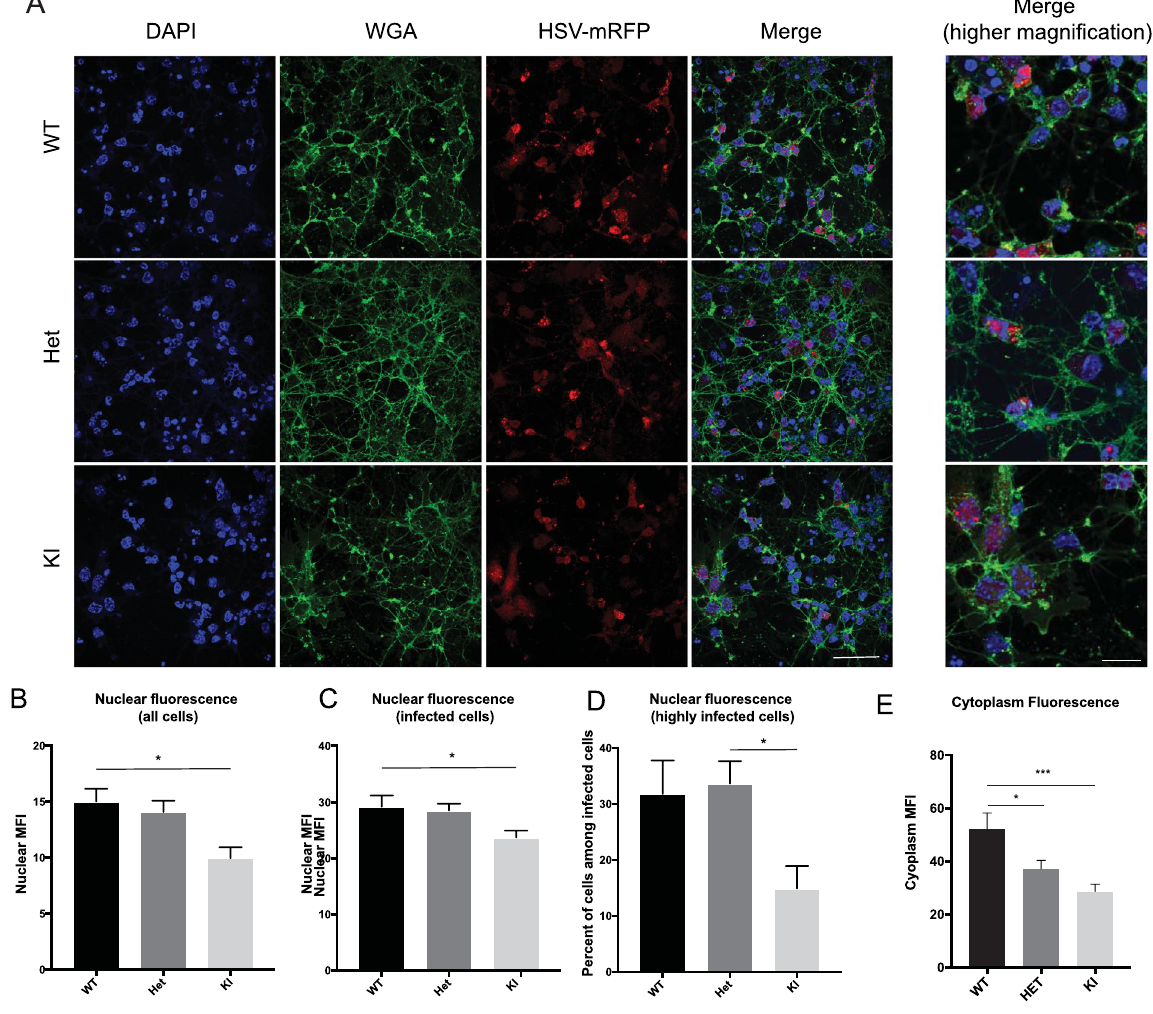
Figure 2. Monitoring HSV infection in nucleus and cytoplasm of neurons. ( A ) Representative images of WT, Het and KI lines infected with HSV-VP26-RFP at the M.O.I. of 1 at 8 h post-infection. Cells were stained for DAPI (blue), WGA-488 (green) and virus is shown in red. Scale bar is 50 μ m, for higher magnification images is 20 μ m. ( B – D ) Mean fluorescent intensity (MFI) in the red channel inside the nucleus for all cells, approximately 600 cells were analyzed per genotype ( B ), or only infected cells (having a mean fluorescent intensity two-times above background, C ). We also analyzed the percentage of highly infected (three-times above background level) cells among all infected cells ( D ). ANOVA was used to compare groups followed by Tukey’s post-hoc test for pairwise comparisons, * p < 0.05. ( E ) Cytoplasm fluorescence was measured by ImageJ for all cells. ANOVA was used to compare groups followed by Tukey’s post-hoc test for pairwise comparisons. WT samples had a significantly higher HSV concentration in the cytoplasm than Het ( * p < 0.05) and KI ( *** p < 0.001) samples. Approximately 500 cells were analyzed from each